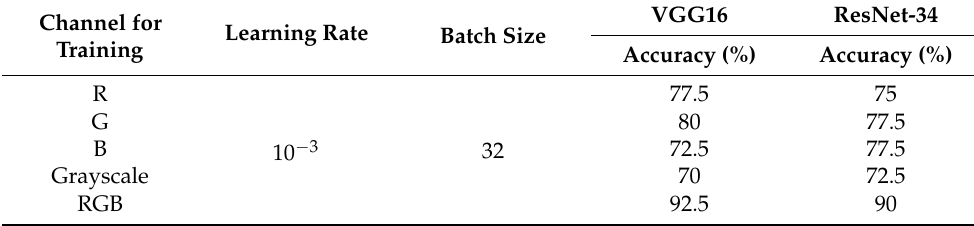
Table 2. The classification accuracy of tea under white-light